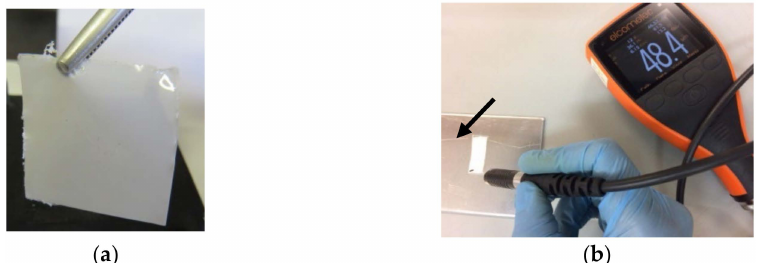
Figure 3. Evaluation of the thickness of the flexible films using the Elcometer ® (Manchester, UK): ( a ) flexible composite film (SNaPZT3); ( b ) measurement of film